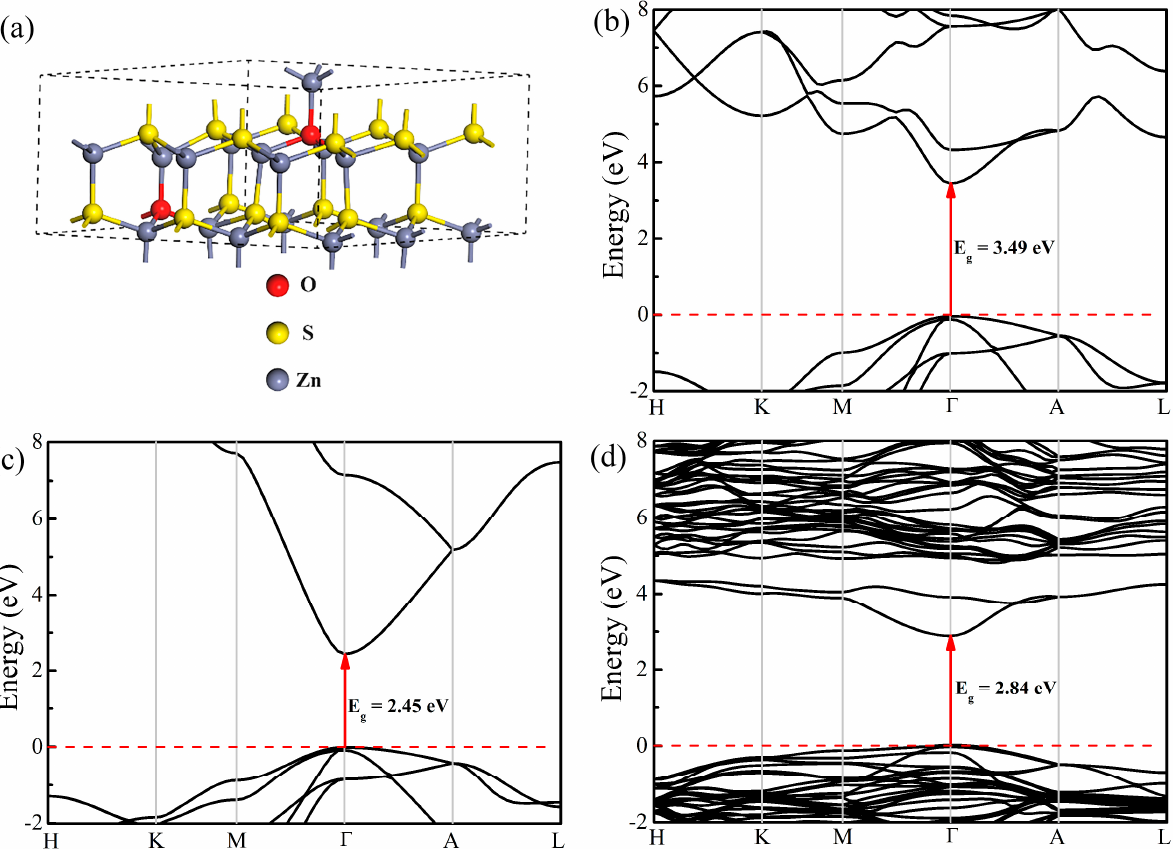
Figure 7. ( a ) Optimized atomic structure of ZnO/ZnS photocatalyst, Band structures near Fermi level for ZnS; ( b ), ZnO; ( c ) and ZnO/ZnS photocatalyst; ( d ) computed at HSE06 level (Fermi levels are set to zero).